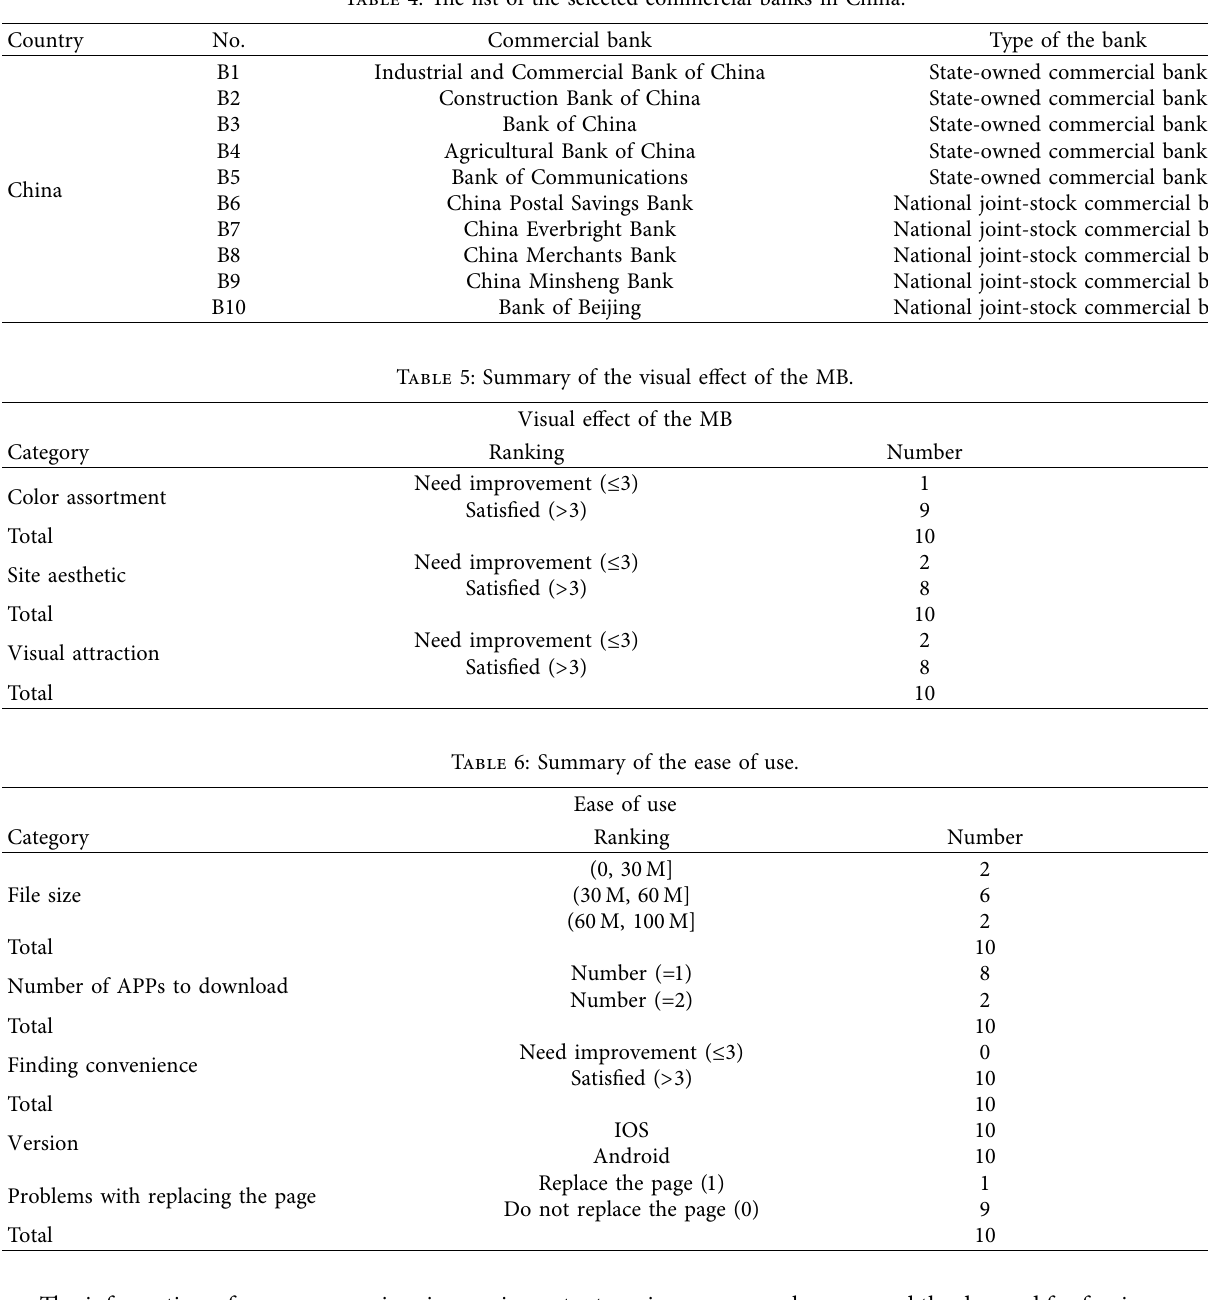
Table 4: The list of the selected commercial banks in China.